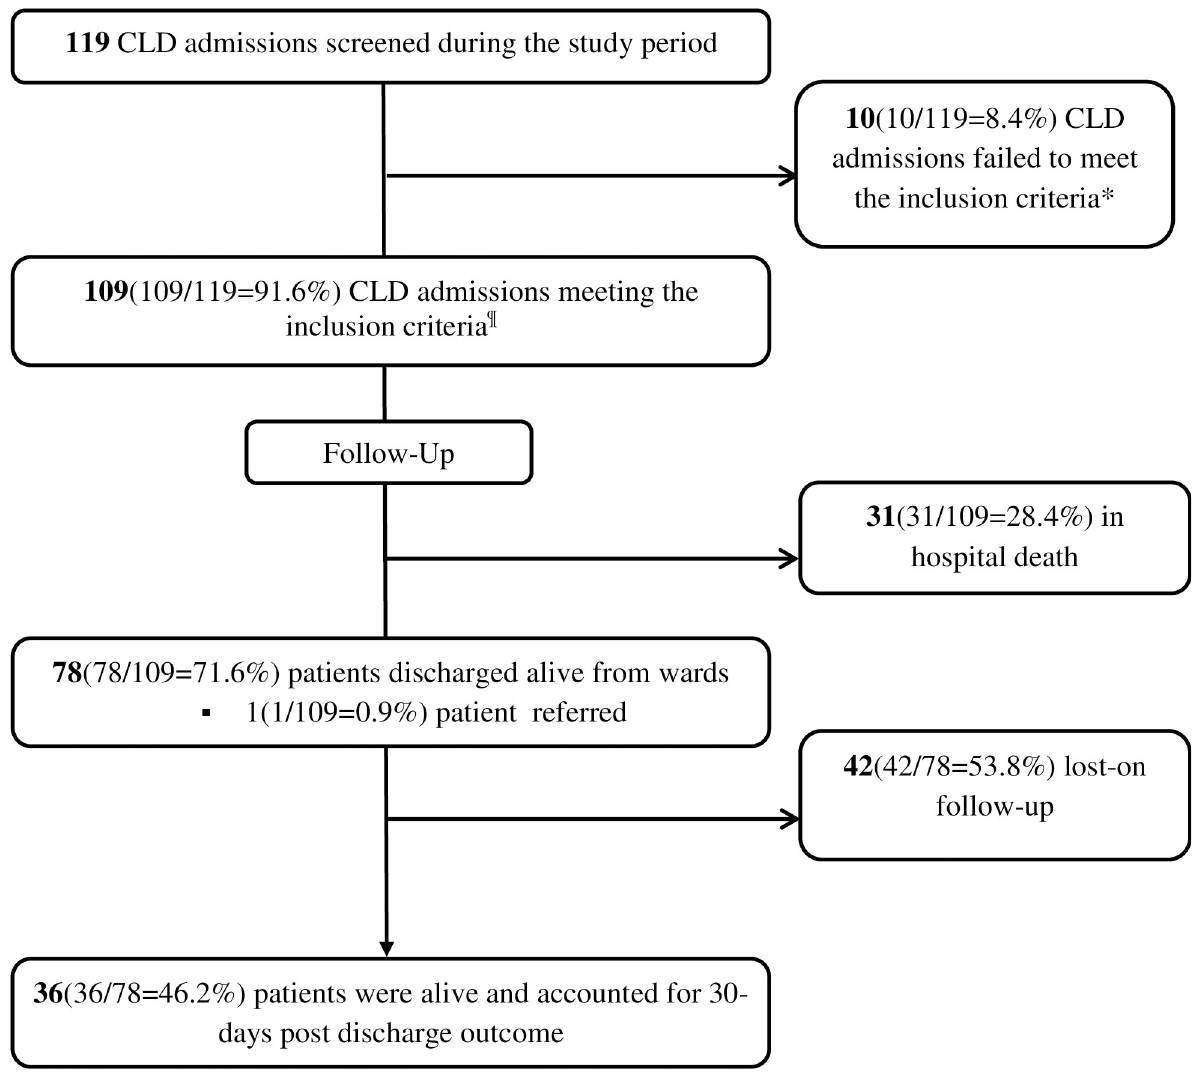
Fig 1. Consort flow chart of admitted CLD patients during the study period and those included in the study. � 3 readmissions, 1 admission for another case other than CLD related complication(s), 4 individuals with a serologic test for viral hepatitis undone, and 2 pregnant women. ¶ Hospitals contribution: JUMC = 61(61.0%), HFSUH = 27(27.0%), SPHMMC = 21(21.0%). Acronyms: JUMC-Jimma university medical center, HFSUH-Hiwot Fana Specialized university hospital, SPHMMC-Saint Paul hospital millennium medical college.